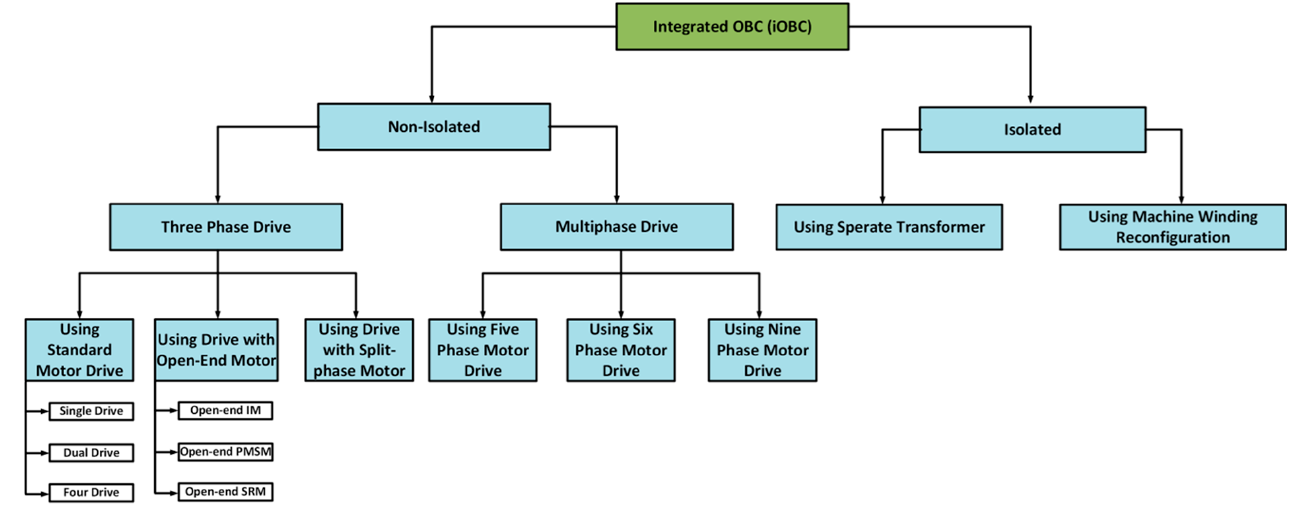
Figure 4. OBC integrated PE converter system topology classification.